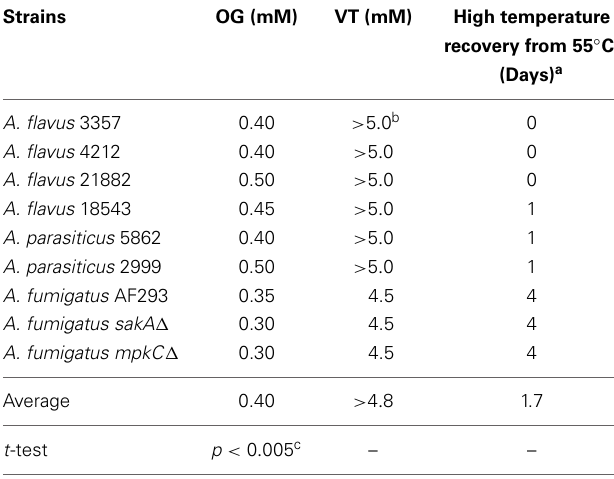
high temperature (55 ◦